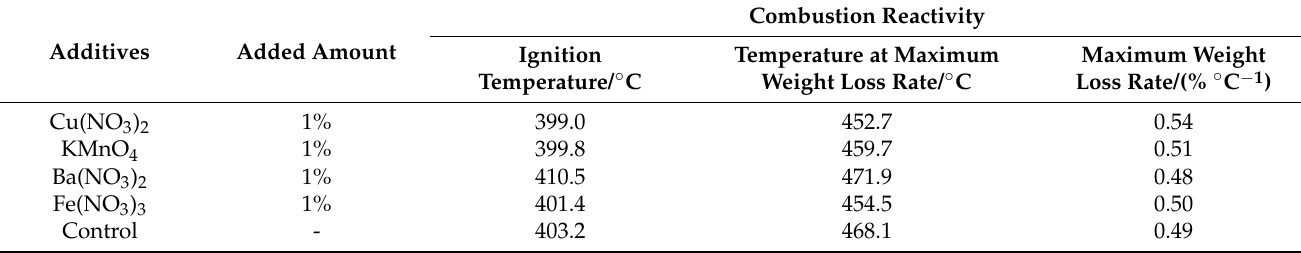
Table 4. Effect of potential additives on the combustion characteristic parameters of MSW